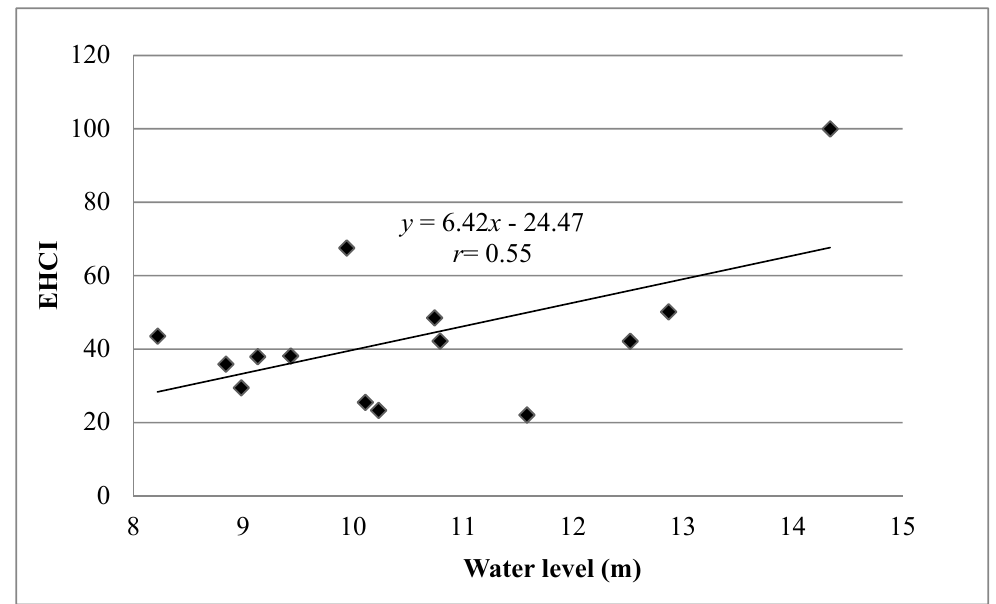
Figure 6. The relationship between the EHCI and water level fluctuation during 1989–2013.